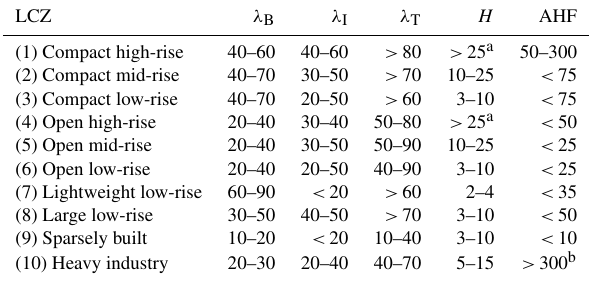
Table 1. A selection of urban canopy parameter data associated with built LCZ types, sourced from Stewart and Oke (2012). Columns represent the urban canopy parameters included in the the- matic benchmark: the percentage of built ( λ B (%), ratio of building plan area to total plan area), impervious ( λ I (%), ratio of impervious plan area (paved, rock) to total plan area), and total impervious ( λ T (%), defined as the ratio of the sum of the building and impervious plan areas to the total plan area) surface areas, the mean height of roughness elements H (m) (geometric average of building heights), and the mean annual anthropogenic heat flux AHF (Wm − 2 ). Max- imum values for H (LCZs 1 and 4 a ) and AHF (LCZ 10 b ) are not available and are arbitrarily set to 200m and 1000Wm − 2 respec- tively. LCZ λ B λ I λ